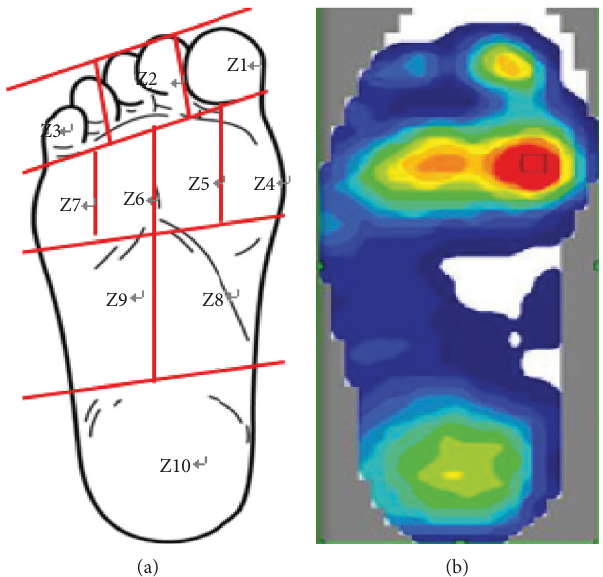
Figure 4: Area division and distribution of plantar pressures while a subject is